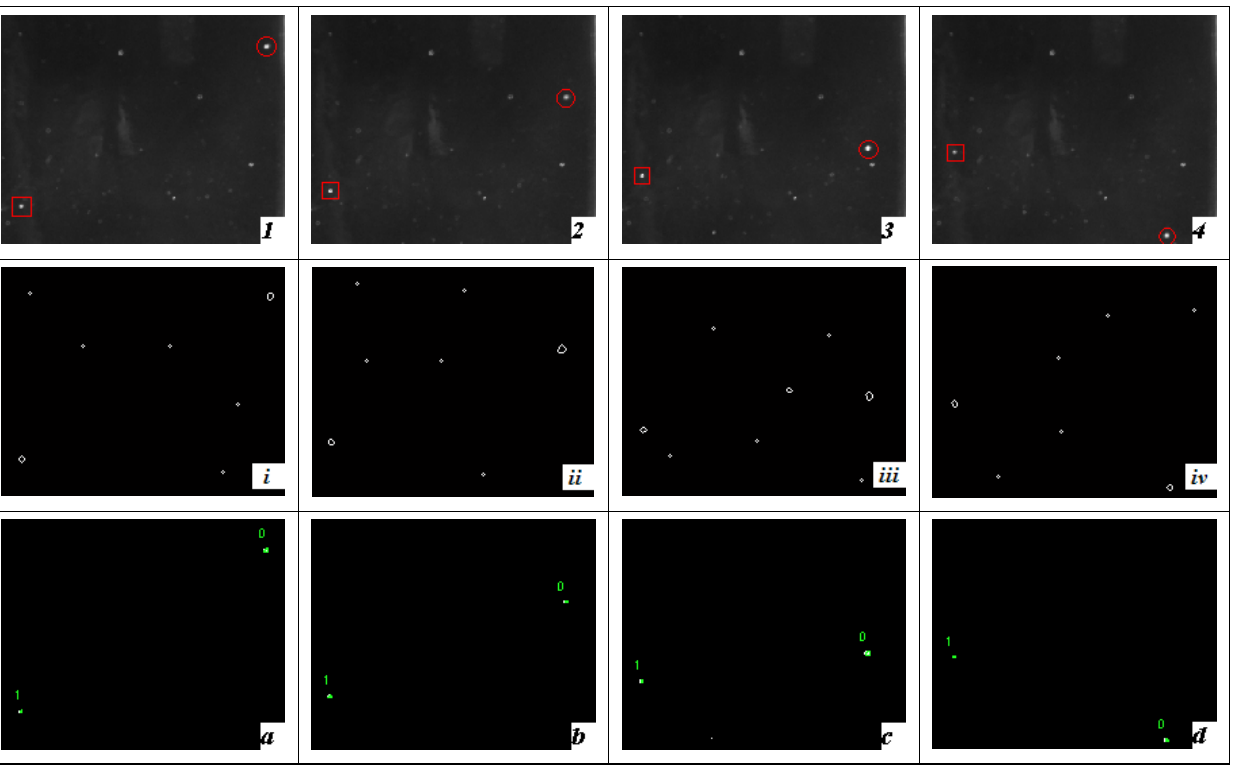
Figure 11. White foreign substances (glass chip) segmentation with bottom light (1-4) sequential images every 200 ms (bubble and glass chip are labeled with red rectangle and circle respectively). (i-iv) Segmentation results with Canny operator. (a-d) Segmentation results with modified PCNN (falling glass chip and rising bubbles are labeled).